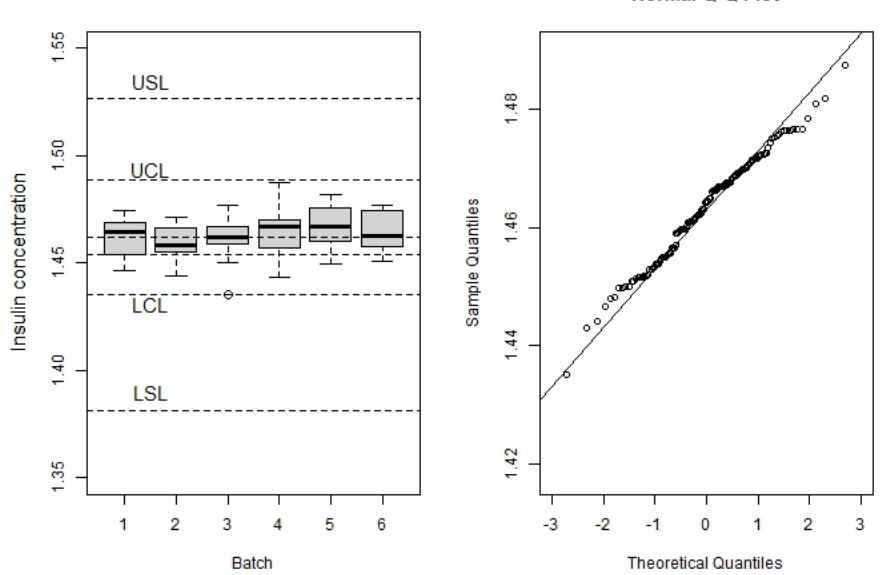
Figure 1. The box plot of the observations by batch, together with the lower and upper specification limits and capabilities ( left ), and Normal Q-Q plot ( right ).